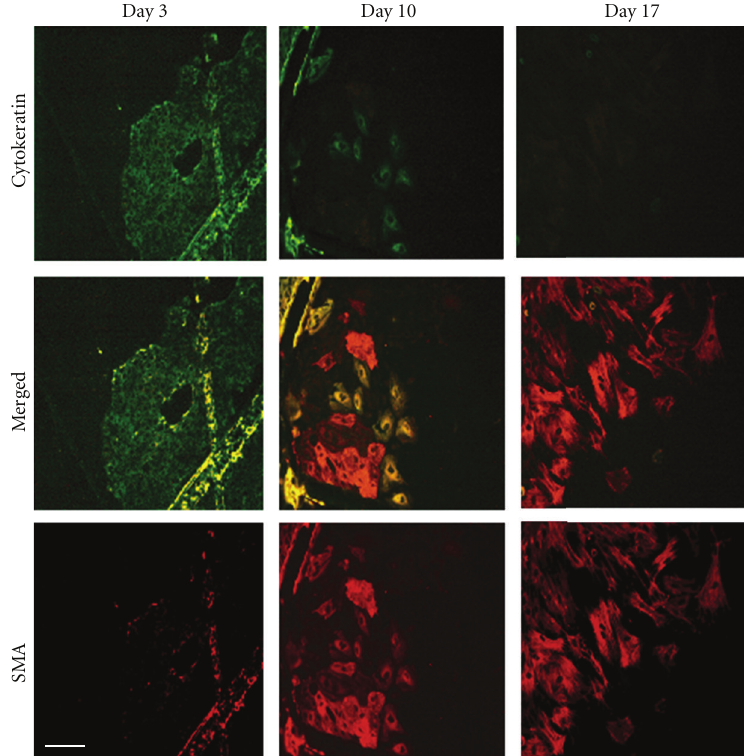
Figure 3: Double labeling for the epithelial marker cytokeratin and the myofibroblast marker SMA was used to determine if cell outgrowths were undergoing EMT. Two-colour immunofluorescence was performed at 3, 10, and 17 days after explanting. By labelling for both SMA (red) and cytokeratin (green), outgrowths were initially epithelial at day 3. By day 10 cell outgrowths expressed both SMA and cytokeratin (yellow) indicating that cells were coexpressing epithelial and mesenchymal markers. By day 17, cells had developed a mesenchymal phenotype, and all stained positive for SMA. Scale bar = 25 μ